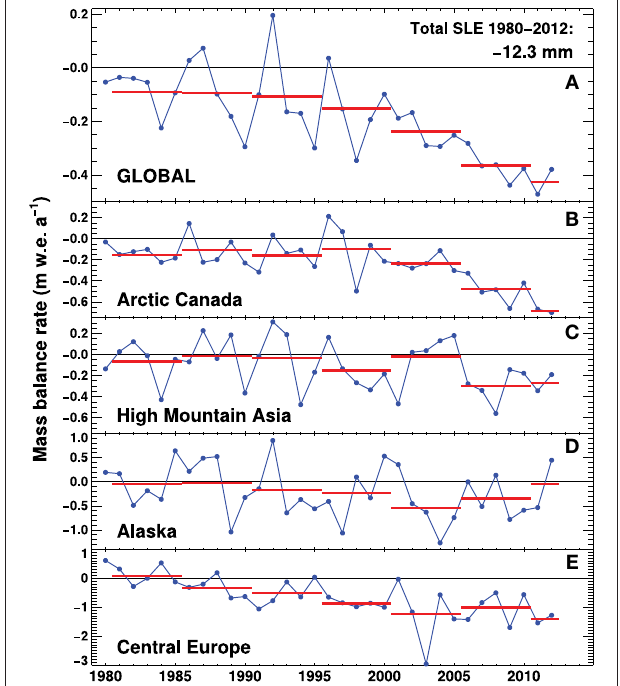
FIGURE 5 | Modeled specific mass balance rates (including climatic balance and frontal ablation) based on ERA-interim data for (A) all glaciers globally, and (B–E) selected regions. Note that the scales differ among the panels. The horizontal bars show pentadal averages.